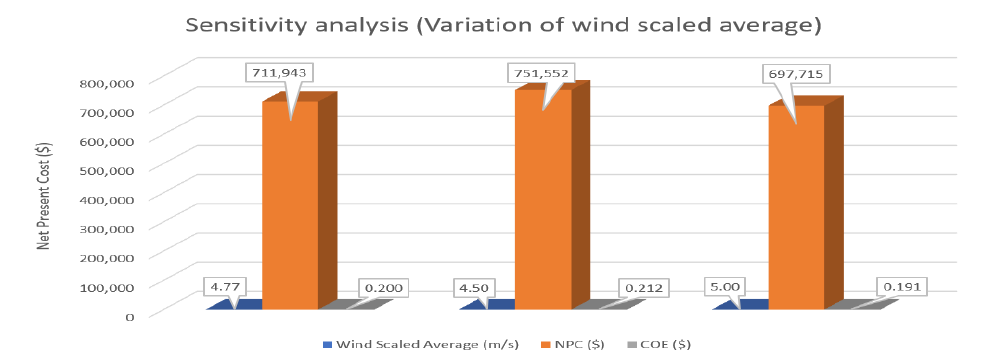
Figure 13. Variation of Wind Speed.